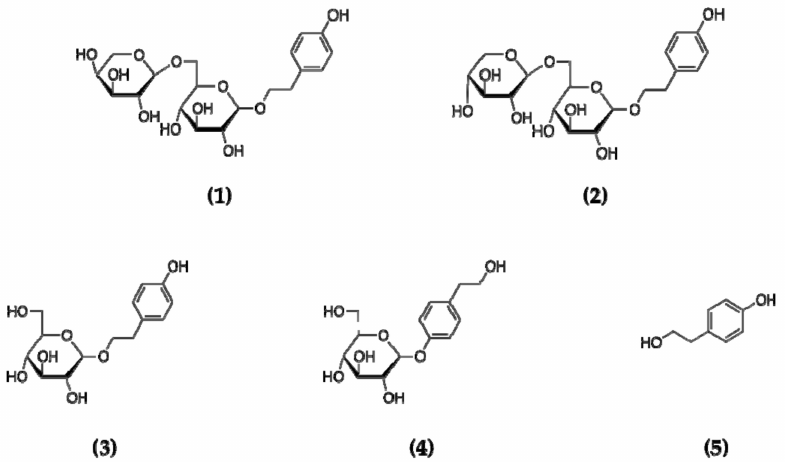
Figure 2. Structures of compounds steviophethanoside ( 1 ); cuchiloside ( 2 ); salidroside ( 3 ); icariside D ( 4 ); tyrosol ( 5